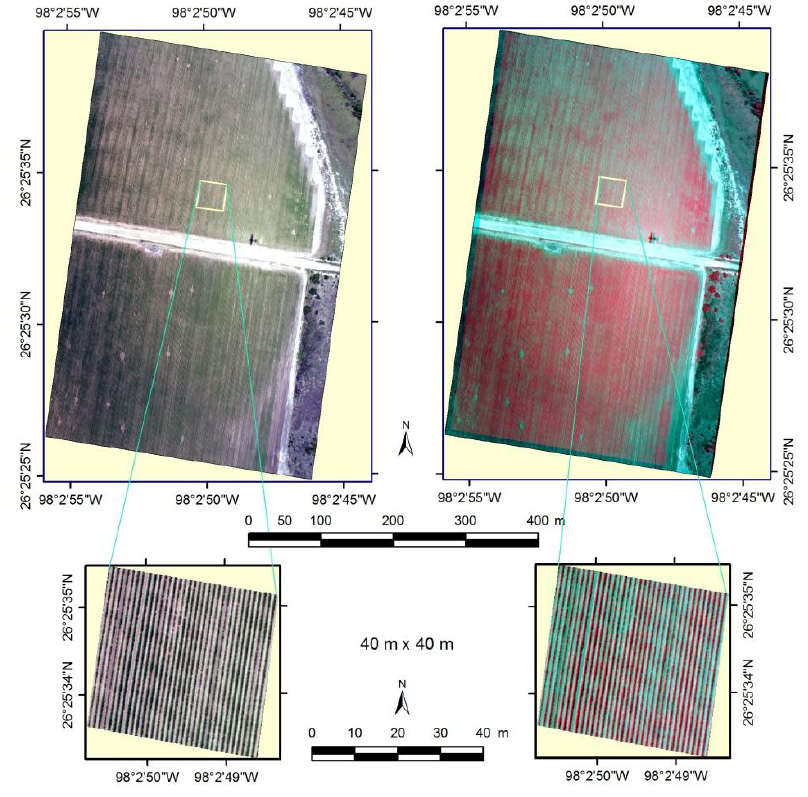
Figure 6. Normal color ( left ) and color-infrared ( right ) images acquired at 305 m (1000 ft) above ground on 17 May 2012 from cotton fields near Hargill, Texas. The images for a close-up area with a 40 m by 40 m square extracted from the full-size image are also